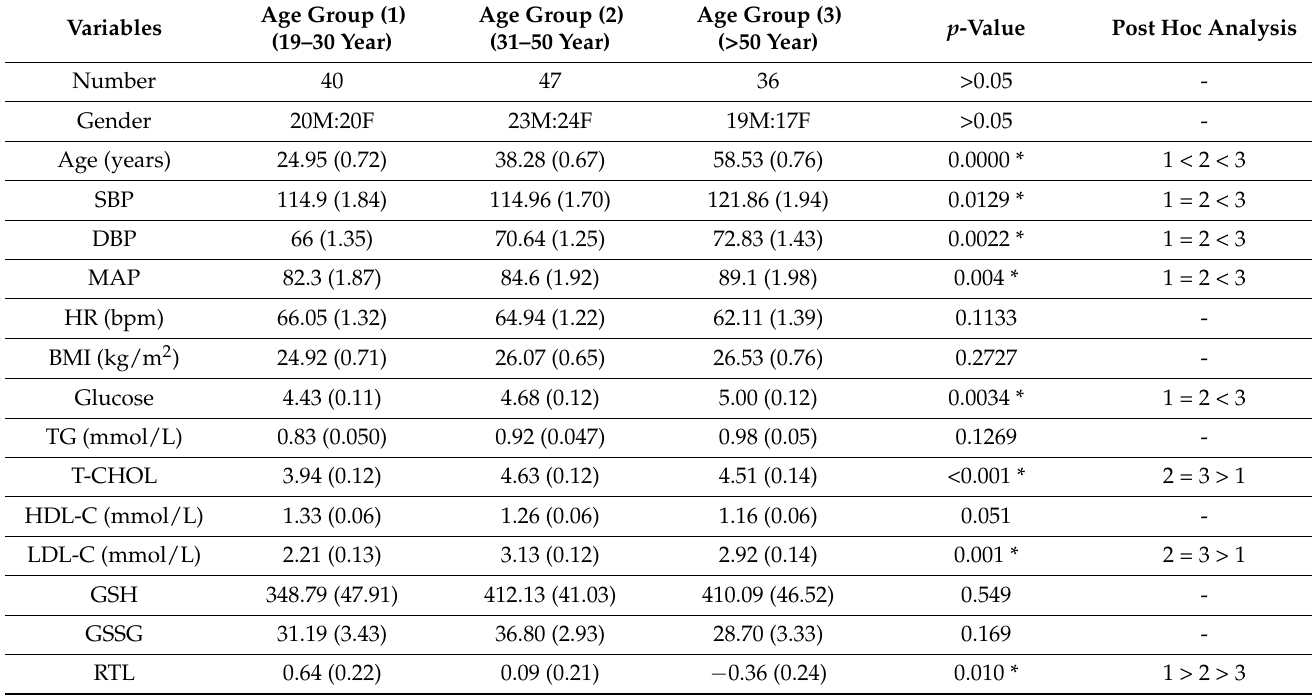
Table 1. General characteristics of the study population.